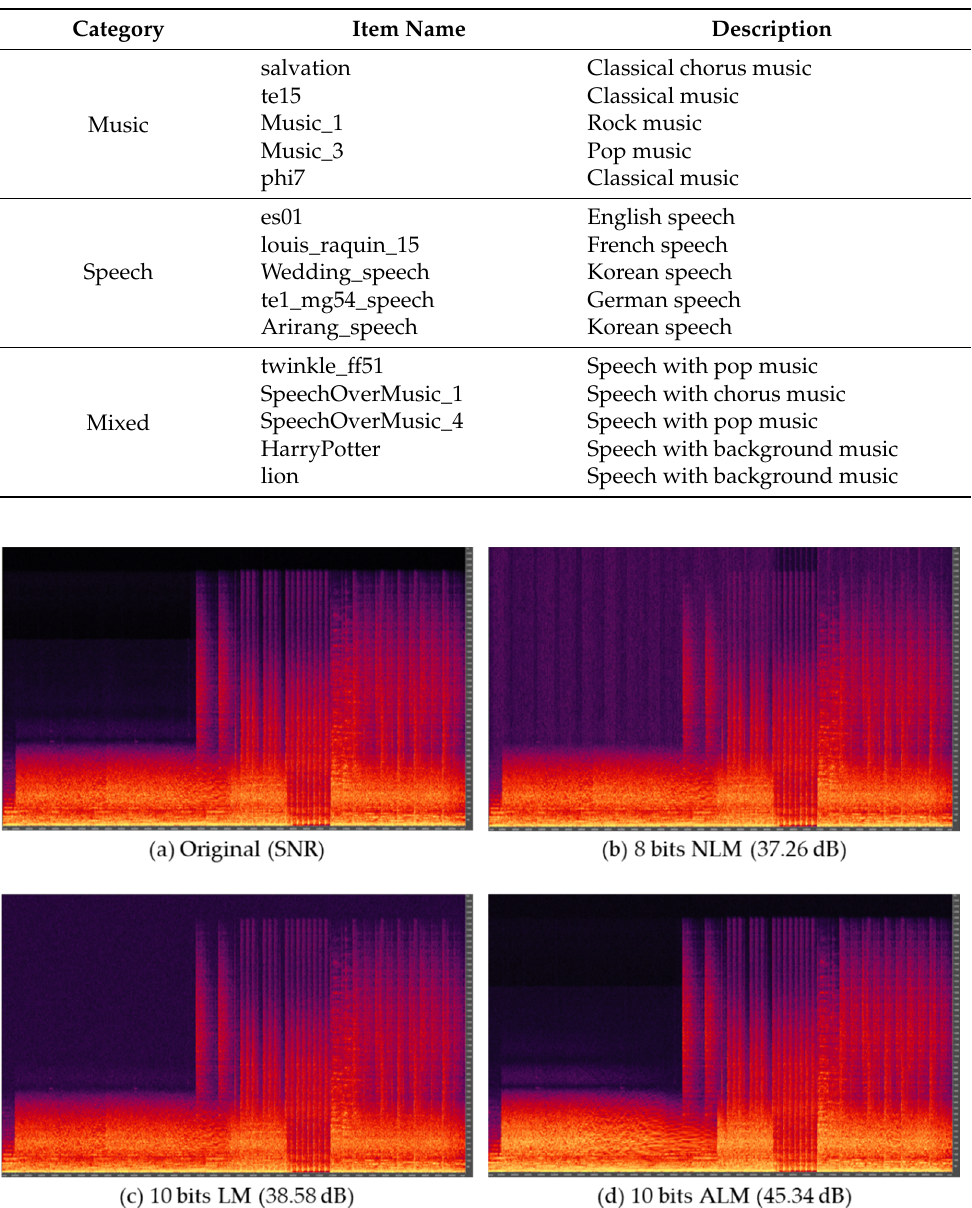
Table 2. Description of audio signal items.